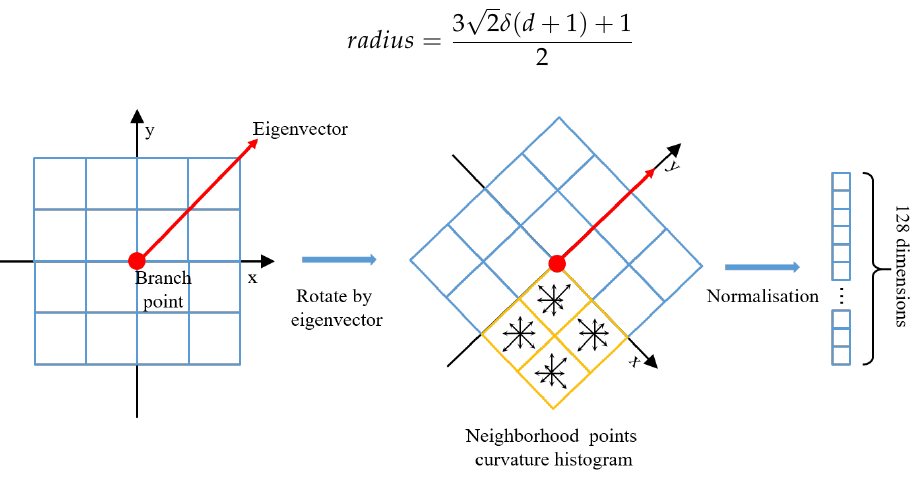
Figure 12. Extraction